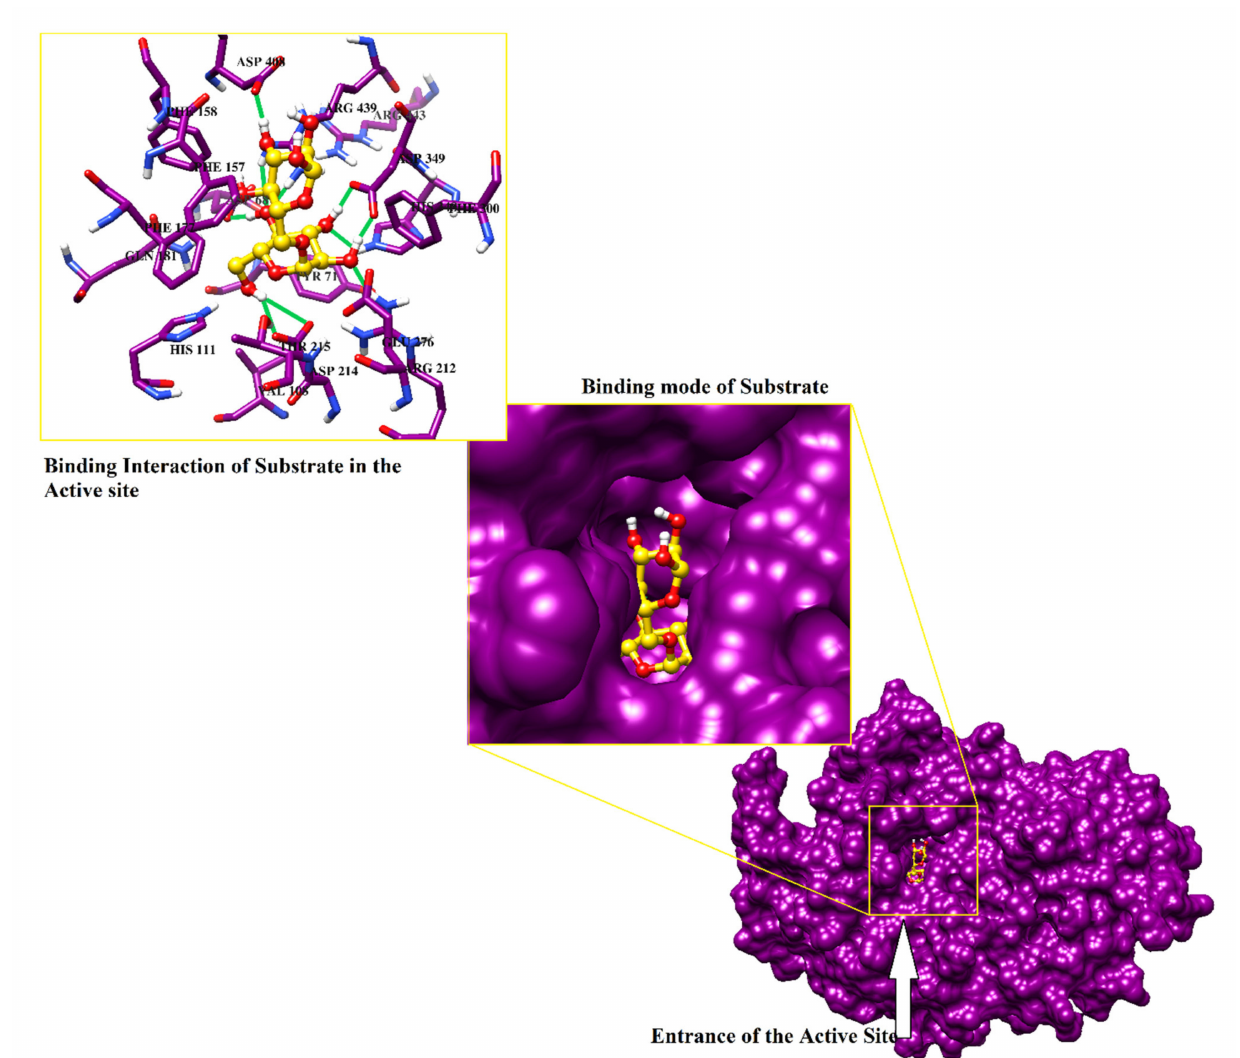
Figure 3. The binding mode of substrate is shown in the active site of enzyme. The binding interactions are highlighted in box. Hydrogen bonds are shown in green